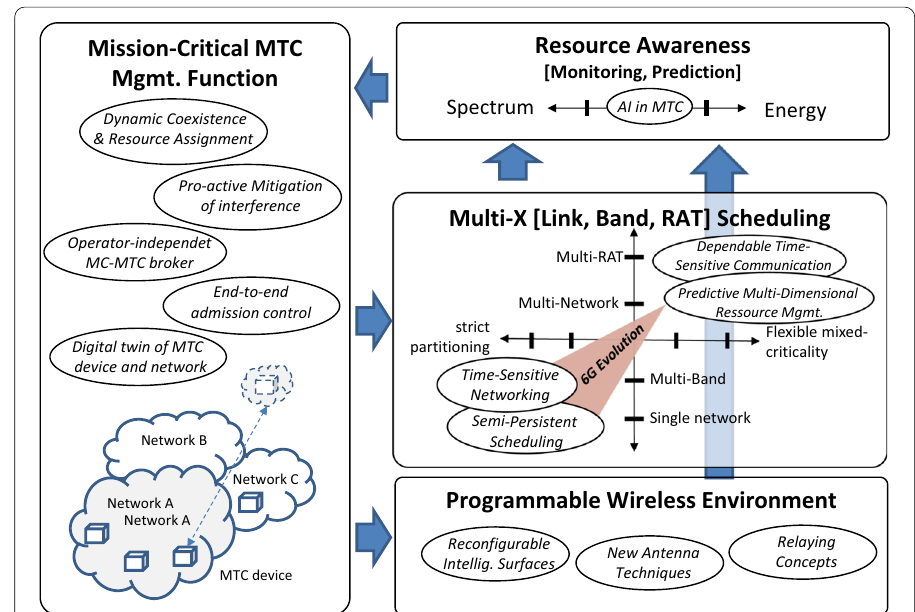
Fig. 6 6G cMTC enablers. 6G Mission‑Critical MTC Solution